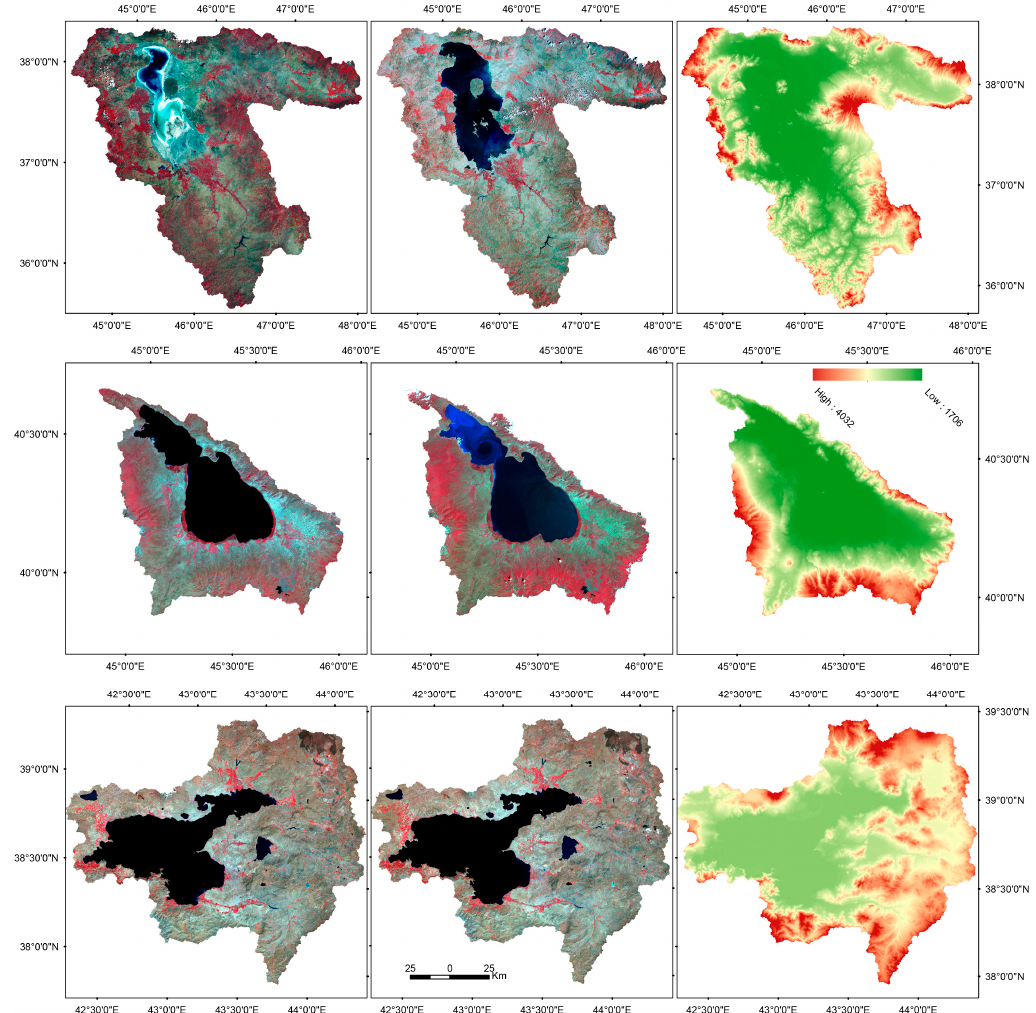
Figure 4. Standard false colour composite of Landsat imagery over Lake Urmia basin (first row); Lake Sevan basin (second row); and Van Lake basin (third row) at two different epochs: 2015 (left column); and 1975 (middle column). In the right column of the figure, the elevation map of the basins has been shown.